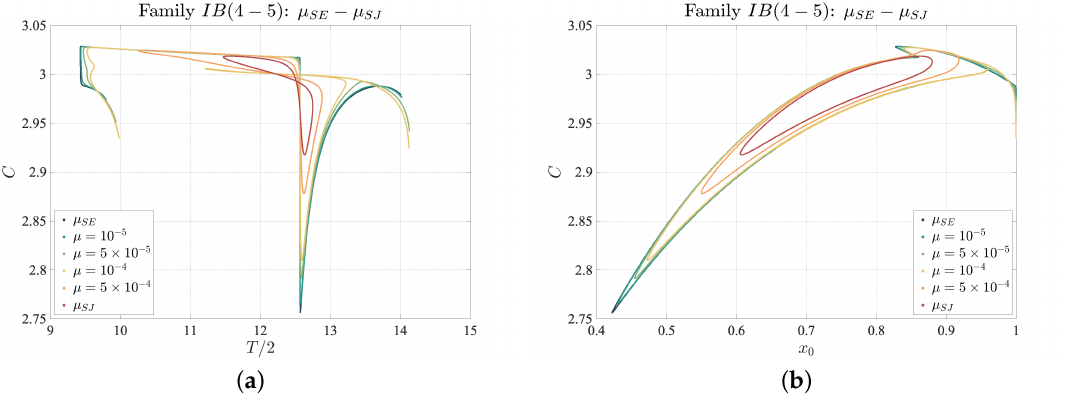
Figure 8. Characteristic curves of the family IB ( 4 − 5 ) continued from the Sun–Earth system ( µ SE ) to the Sun–Jupiter system ( µ SJ ). ( a ) Family IB ( 4 − 5 ) shown in the T − C plane; ( b ) family IB ( 4 − 5 ) shown in the x 0 − C plane. T /2 is half the orbital period in the synodic frame. C is the Jacobi constant. x 0 is the initial state of the periodic orbits on the x -axis. Different colors indicate different mass parameters.